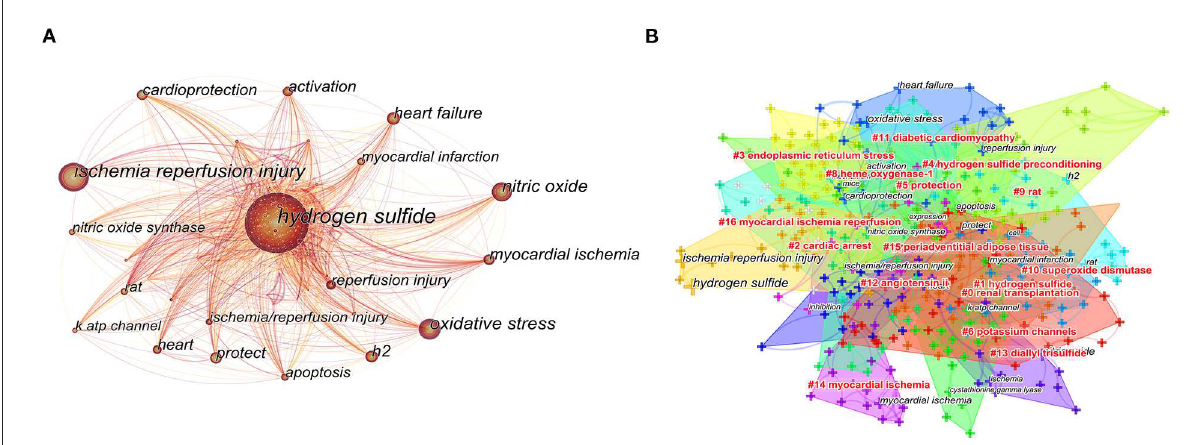
FIGURE6 Analysis of keyword co-occurrence (A) CiteSpace network visualization map of co-occurring keywords (B) CiteSpace network visualization map of co-occurring keyword clusters.